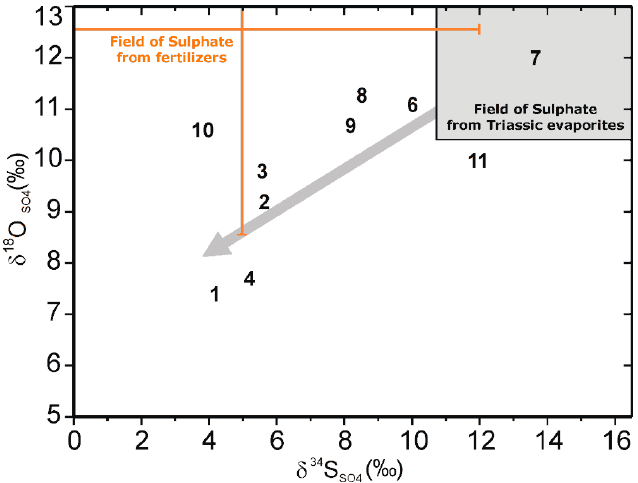
Figure 9. Distribution of values for δ 34 S versus δ 18 O SO4 for dissolved sulfate in the May 2009 field campaign sample. Source: Fields of occurrence of each source of sulfate (Triassic evaporites and fertilizers) adopted from [19].